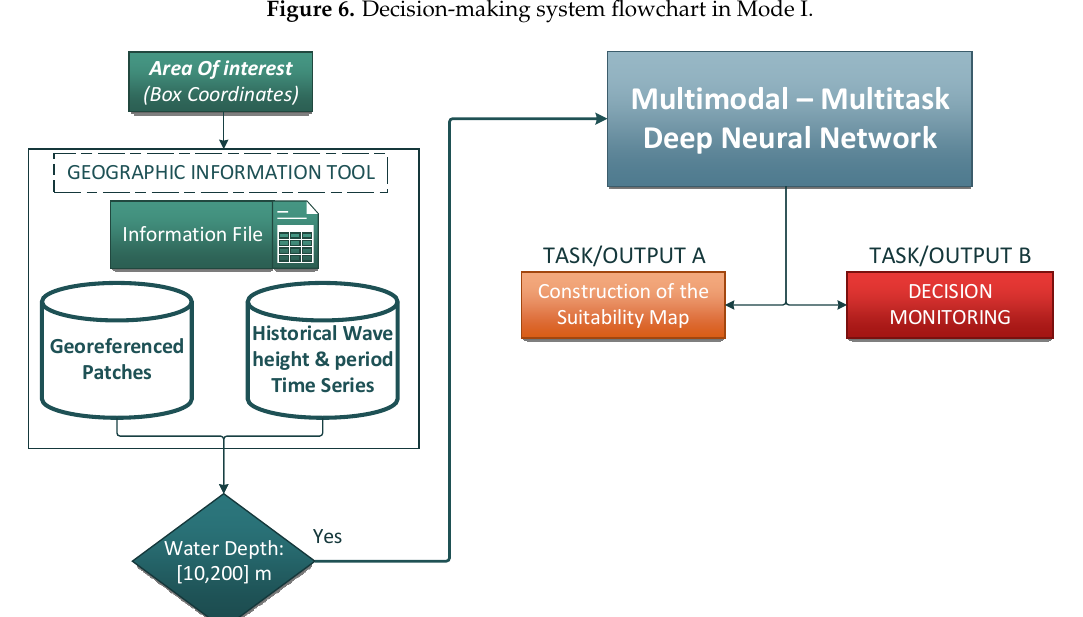
Figure 7. Decision-making system flowchart in Mode II.